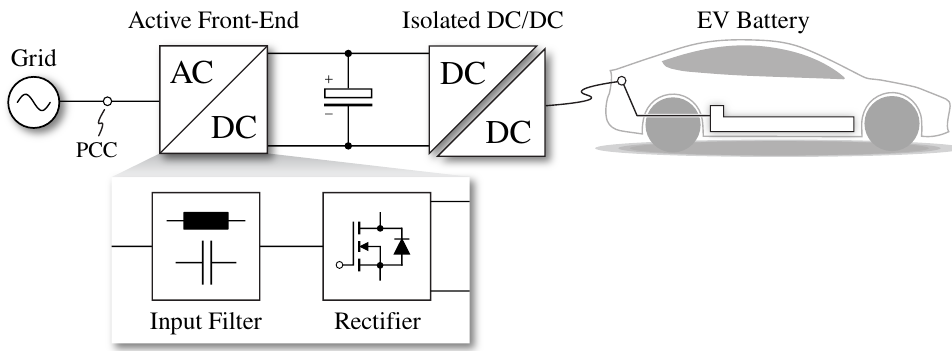
Figure 1. Schematic overview of an electric vehicle (EV) ultra-fast battery charger, with highlight of the active front-end (AFE)